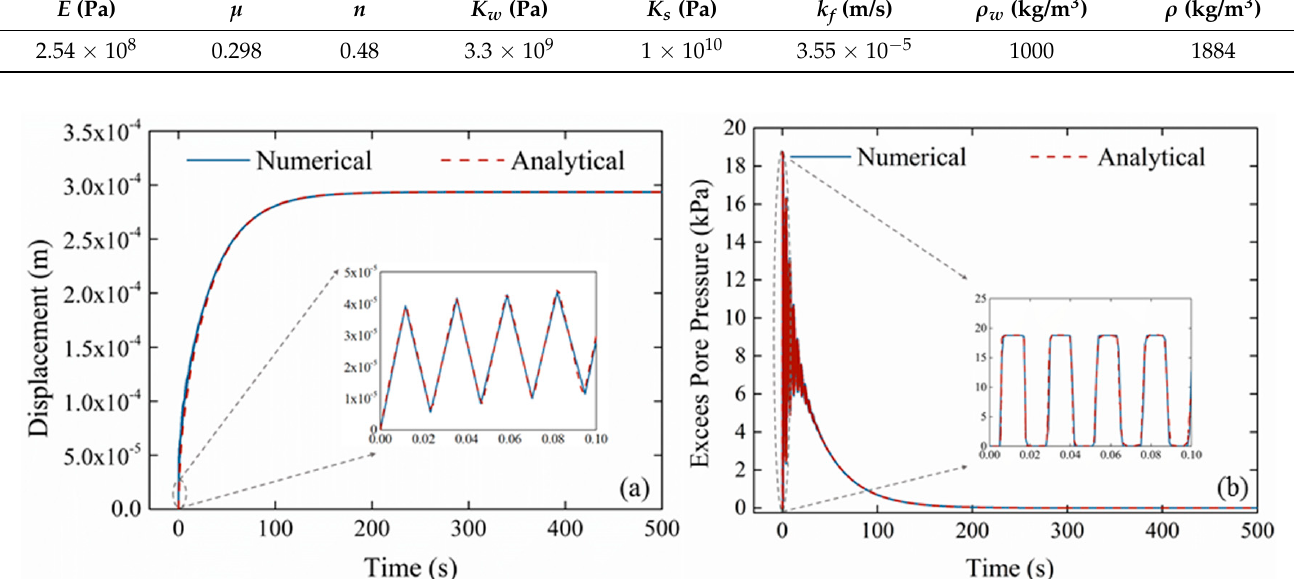
Figure 2. Comparison of numerical and analytical solutions for a 1D dynamic consolidation problem: ( a ) Vertical displace- ment at point 1; ( b ) Excess pore water pressure at point 2.